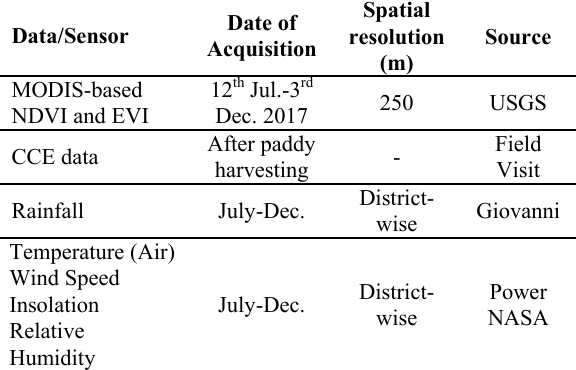
Table 1. Details characteristics of data